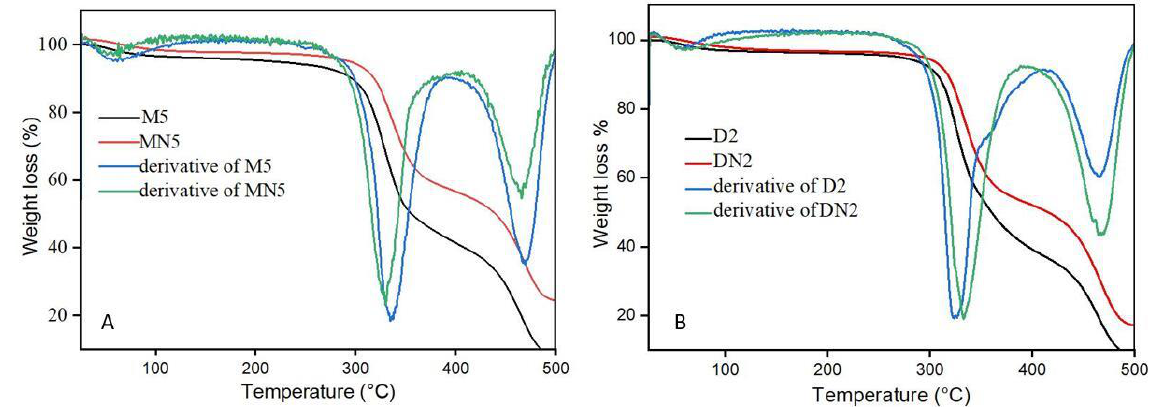
Figure 4. ( A ) TGA spectra of M5 and MN5, ( B ) TGA spectra of D2 and DN2.